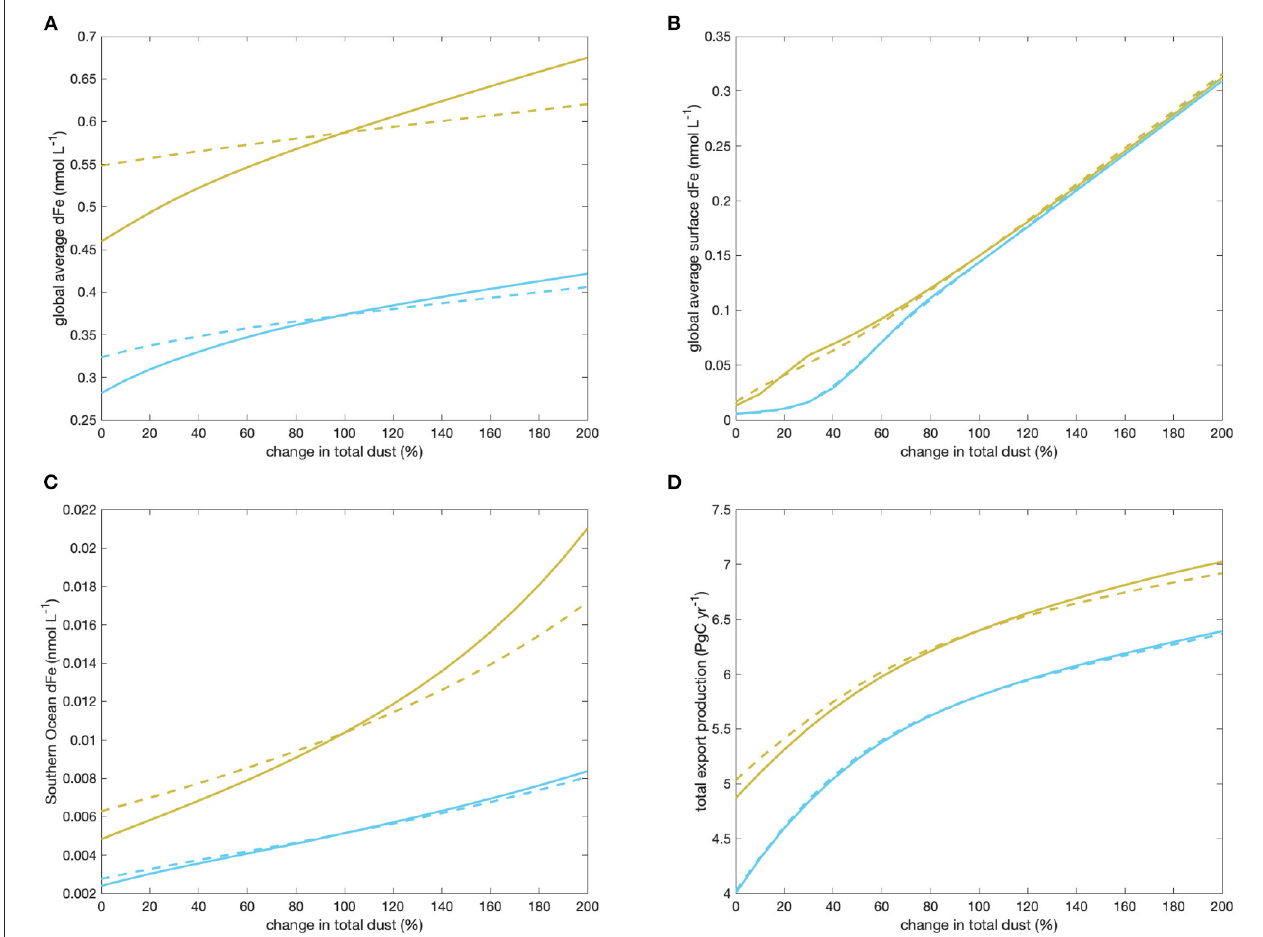
FIGURE 7 | Changes in global average dFe concentration (A) , surface-average dFe (B) , Southern Ocean dFe (C) , and global export production (D) in the model with two types of ligands, as the magnitude of the total dust is varied, including (solid lines) and excluding (dashed lines) the feedback through changes in ligand concentrations. Cyan lines are for model setup 2L , yellow for 2H